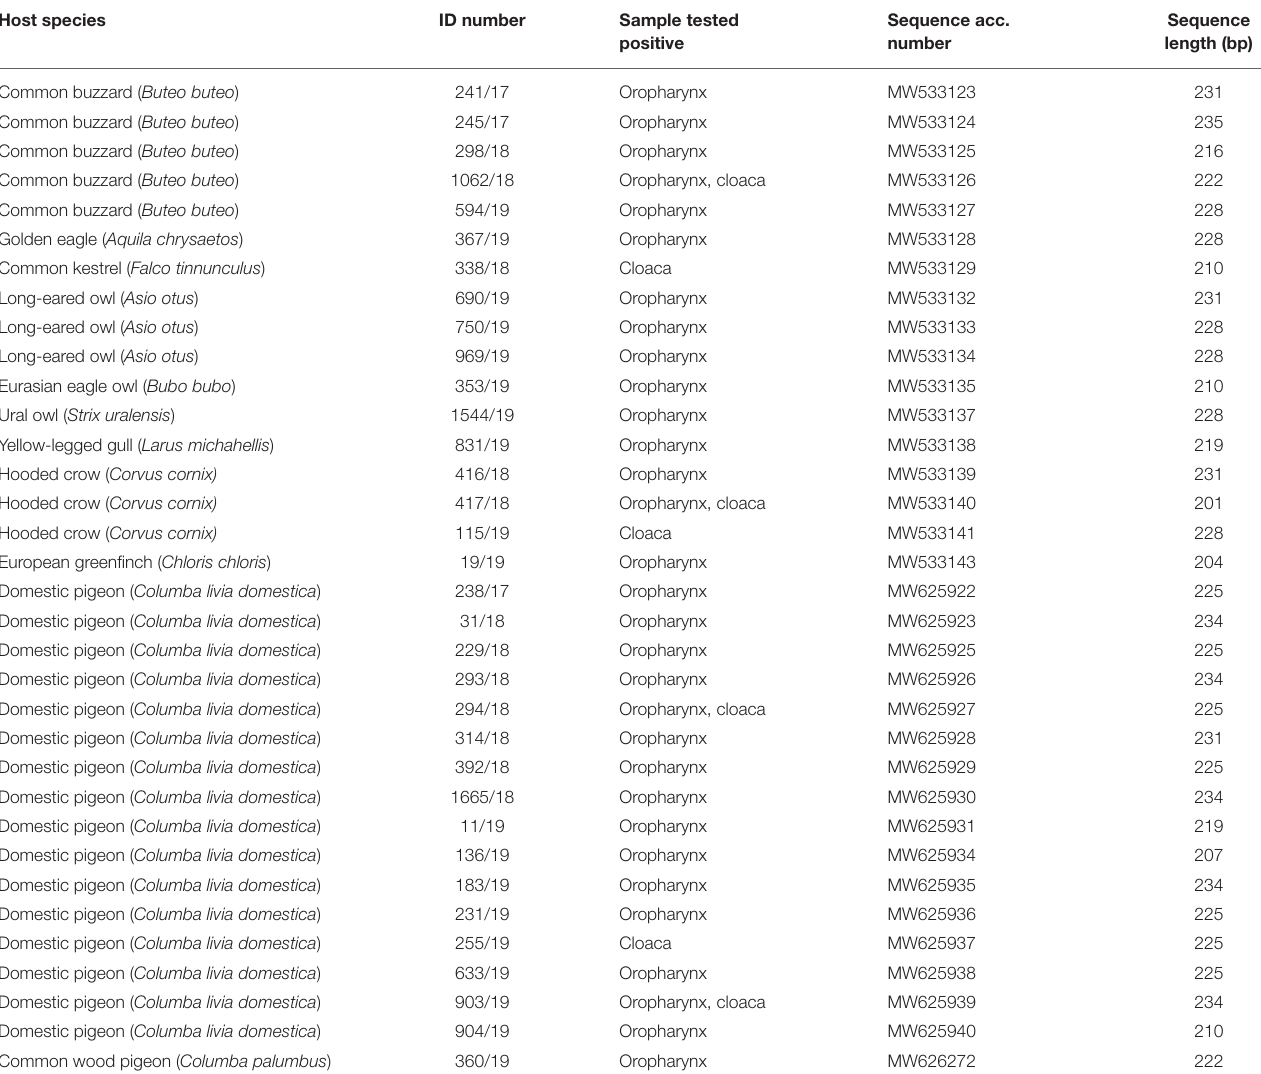
TABLE 2 | Details of HV sequences obtained in this